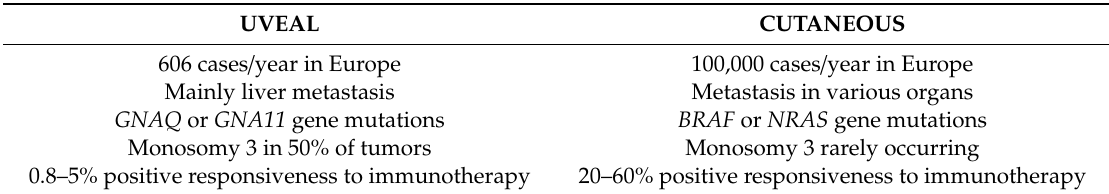
Table2. Maindi ff erencesbetweenuvealandcutaneousmelanomaandtheirresponsetoimmunotherapy with check-point